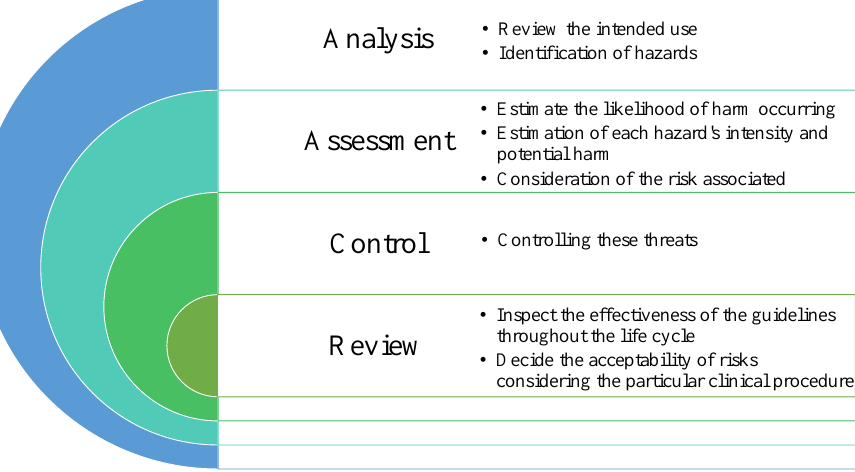
Figure 8. Risk-management process of ISO